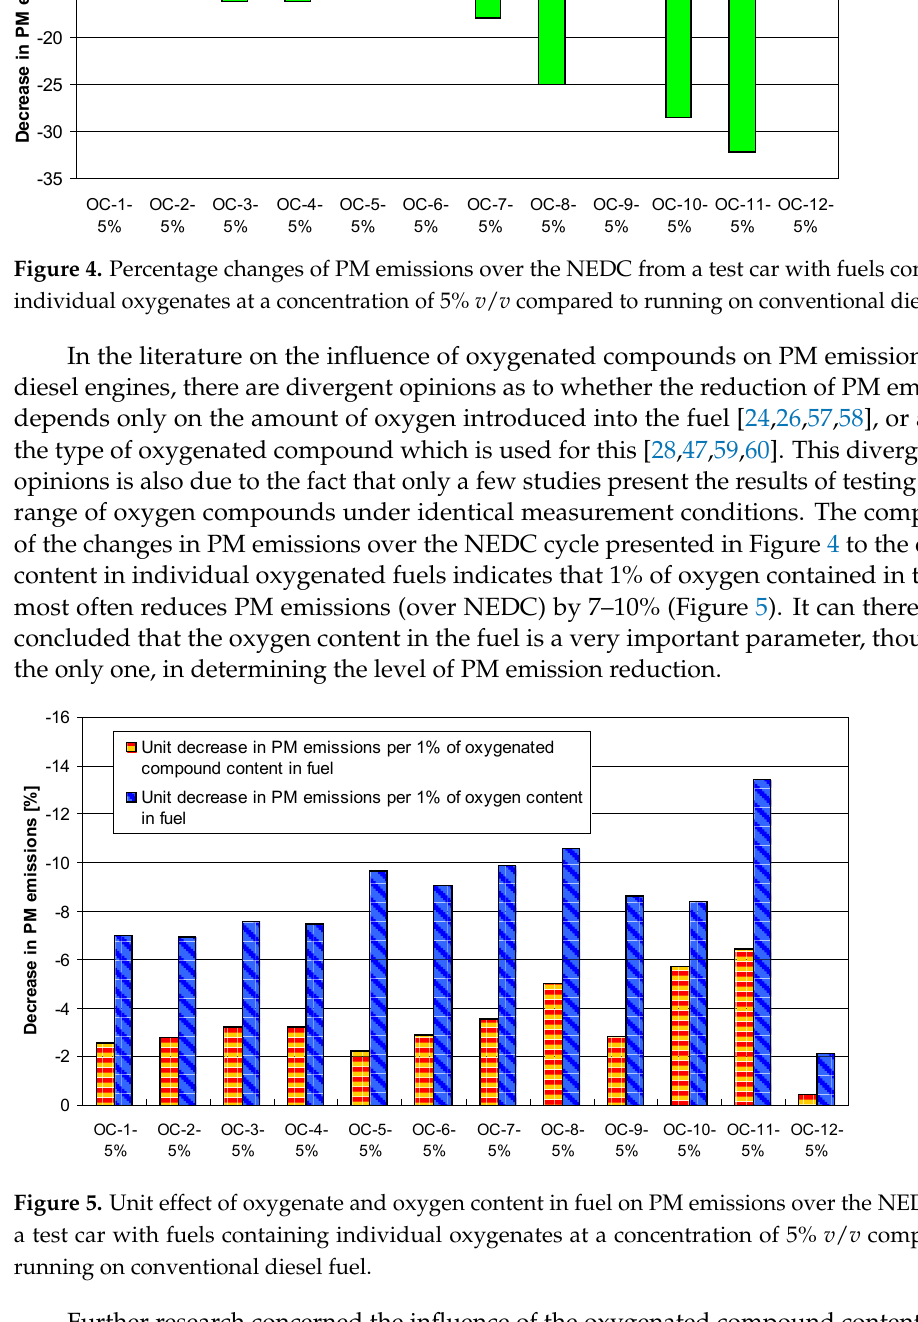
Figure 6. Reduction of PM emissions as a function of type and content of oxygenated compound in relation to fueling with conventional diesel fuel. The last part of the authors’ research concerned the influence of the test cycle condi- tions on the obtained effects in PM emission reduction. Figure 7 shows a comparison of the impact on PM emissions of fuels containing 10% of individual oxygenated compounds obtained under the conditions of the NEDC and FTP-75 (US Environmental Protection Agency Federal Test Procedure) test cycles. The American cycle (FTP-75) is a more dy- namic, non-stationary cycle, while in the European cycle there is a higher maximum speed. Ultimately, based on the measurement results, it can be concluded that, for the same fuels, a greater reduction of PM emissions occurs under the NEDC cycle conditions. The use of glycol ethers as fuel components for diesel engines also in studies pre- sented by other authors led to a reduction in the emission of particulate matter (soot). In Zannis et al. [61], soot emissions from a single-cylinder direct-injection diesel engine using city diesel fuel and two blends of this fuel and glycol ethers were tested. Each blend con- tained diethylene glycol dimethyl ether (so-called diglyme) and diethylene glycol dibutyl ether (so-called butyl diglyme) in approximately equal proportions. The first blend (named GLY10) contained about 10% glymes and the second (named GLY30) about 30%. This corresponded to 3% and 9% m / m oxygen content in the fuel mixture, respectively. The soot emissions were measured under conditions of constant speed (2500 rpm) and variable load. The emission of soot for the fuel containing 3% oxygen was higher than for neat diesel fuel; however, for the fuel containing 9% oxygen, it decreased on average by about 20%. It is worth noting that GLY 30 fuel had a very high cetane number (73).